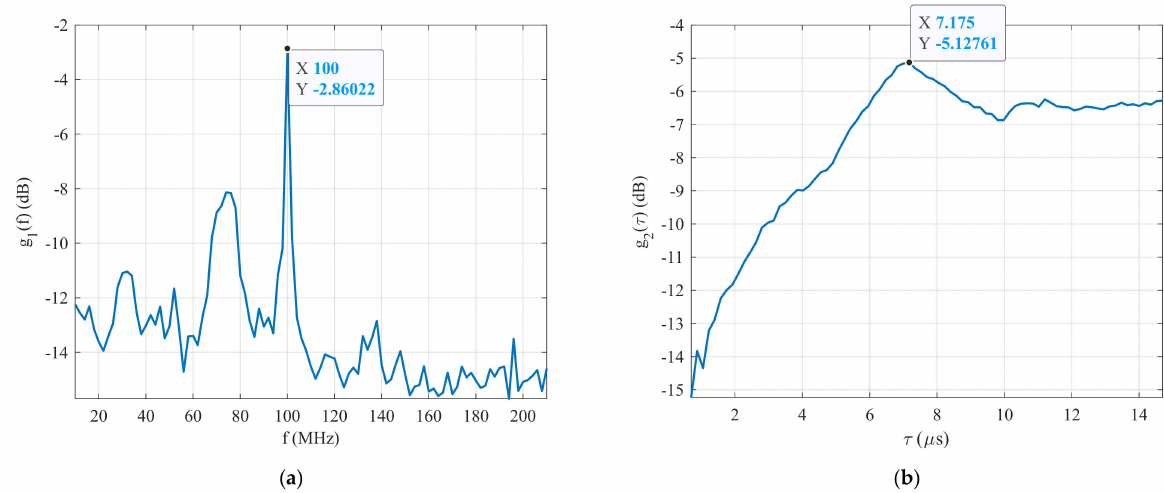
Figure 10. The simulation results: ( a ) detection process, and ( b ) pulse width